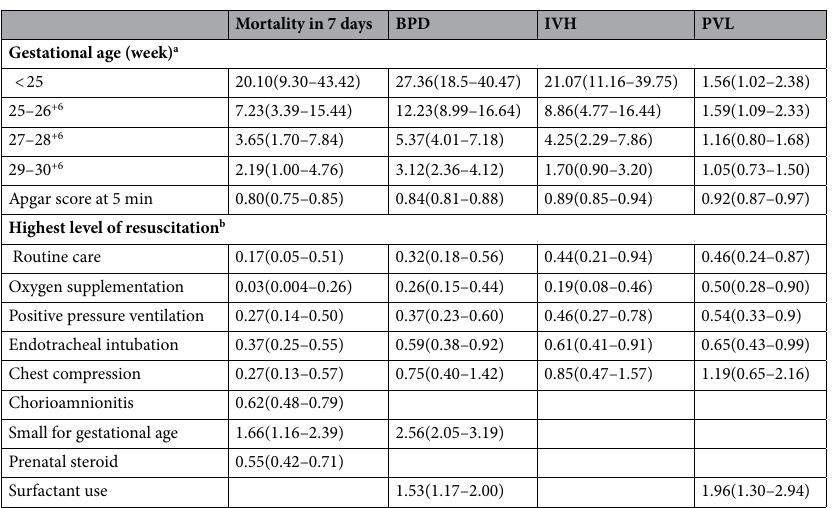
Table 2. Analysis of the risk factors for morbidity in 7 days, BPD, IVH, and PVL using multivariable mixed regression model. Only statistically significant variables (P < 0.05) are shown as adjusted odds ratio (95% confidential intervals). BPD bronchopulmonary dysplasia, IVH intraventricular hemorrhage, PVL periventricular leukomalacia. a Gestational age ≥ 31 weeks is the reference level. b Epinephrine use is the reference